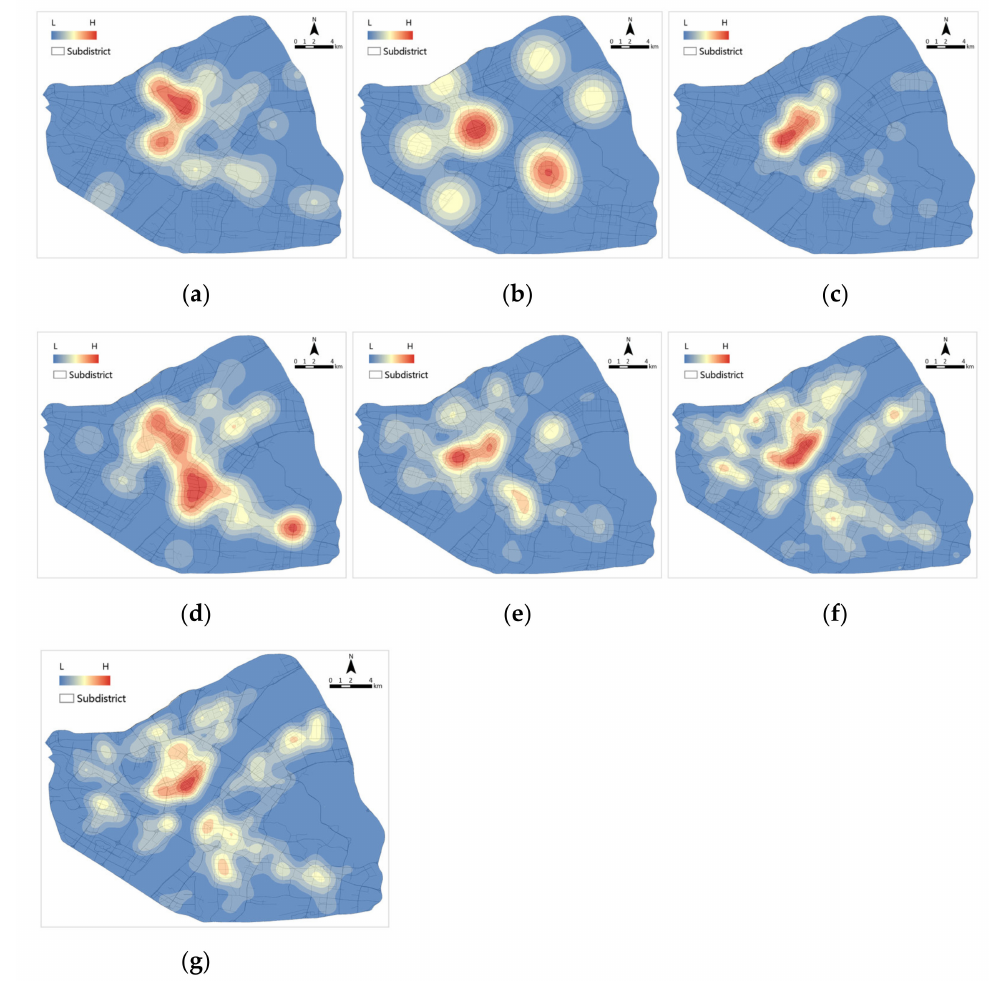
Figure 8. Kernel density distribution of medical facilities: ( a ) COVID-19-designated hospital; ( b ) Fang- cang shelter hospital; ( c ) tertiary hospital; ( d ) secondary hospital; ( e ) primary hospital; ( f ) community clinic; ( g )